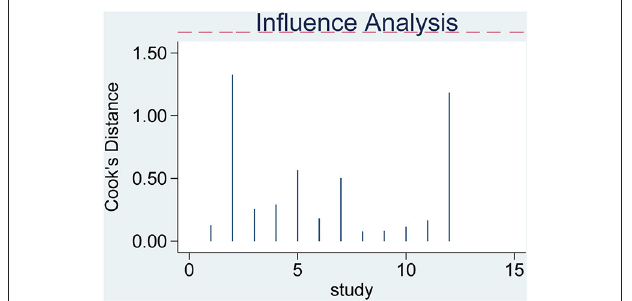
FIGURE 6 | Sensitivity analysis.